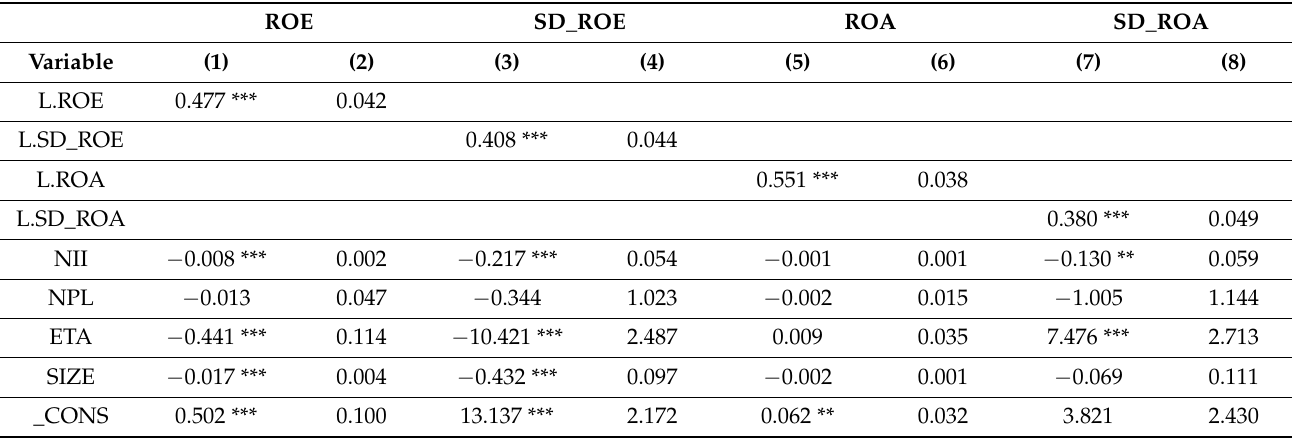
Table 4. Impact of non-interest income on banks’